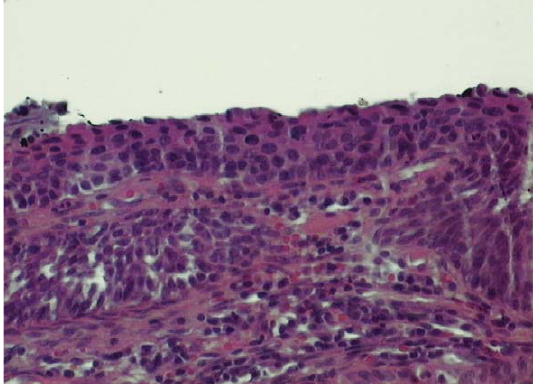
Fig. 2. CIN 3 recurring